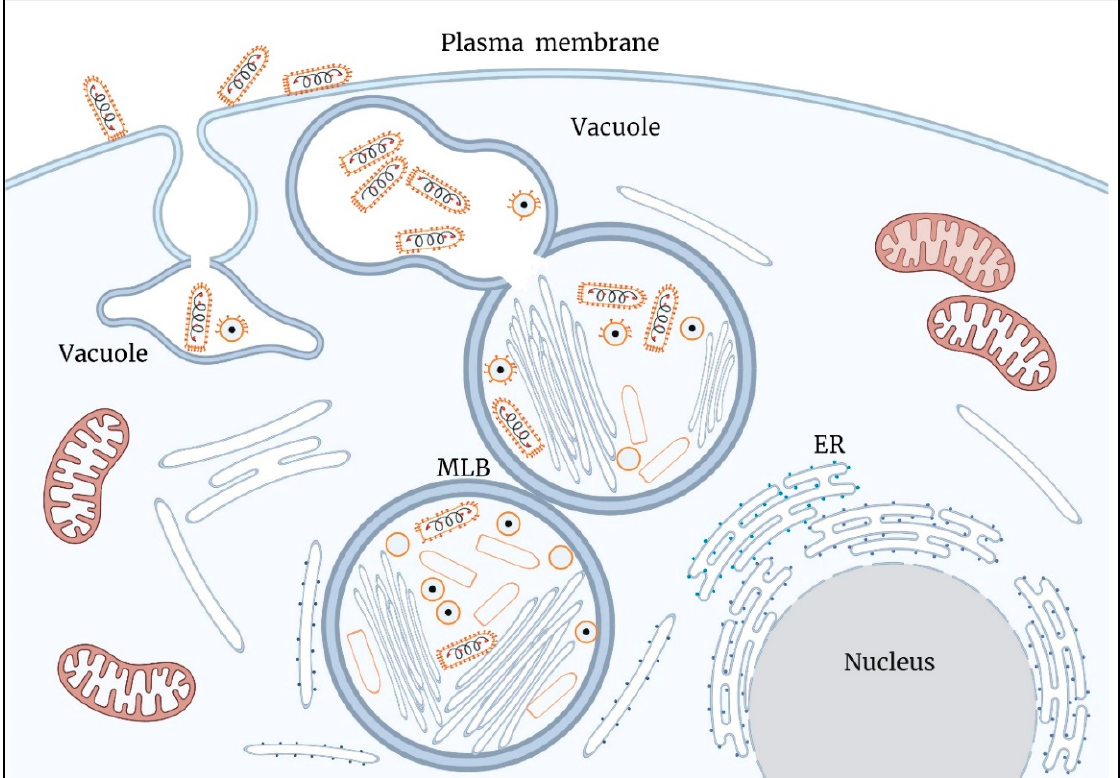
Figure 9. A model illustrating key processes in the infection cycle of VSV-S. Assembly and genome packaging of VSV-S particles is carried out in viral factories (VF) generated in multi lamellar bodies (MLB) located in the cytoplasm. Host ER membranes surround the MLB. Newly formed virus particles decorated by spike proteins are found in a vacuole connected to the MLB. Egress of VSV-S is accompanied by the fusion of the vacuole membrane and plasma